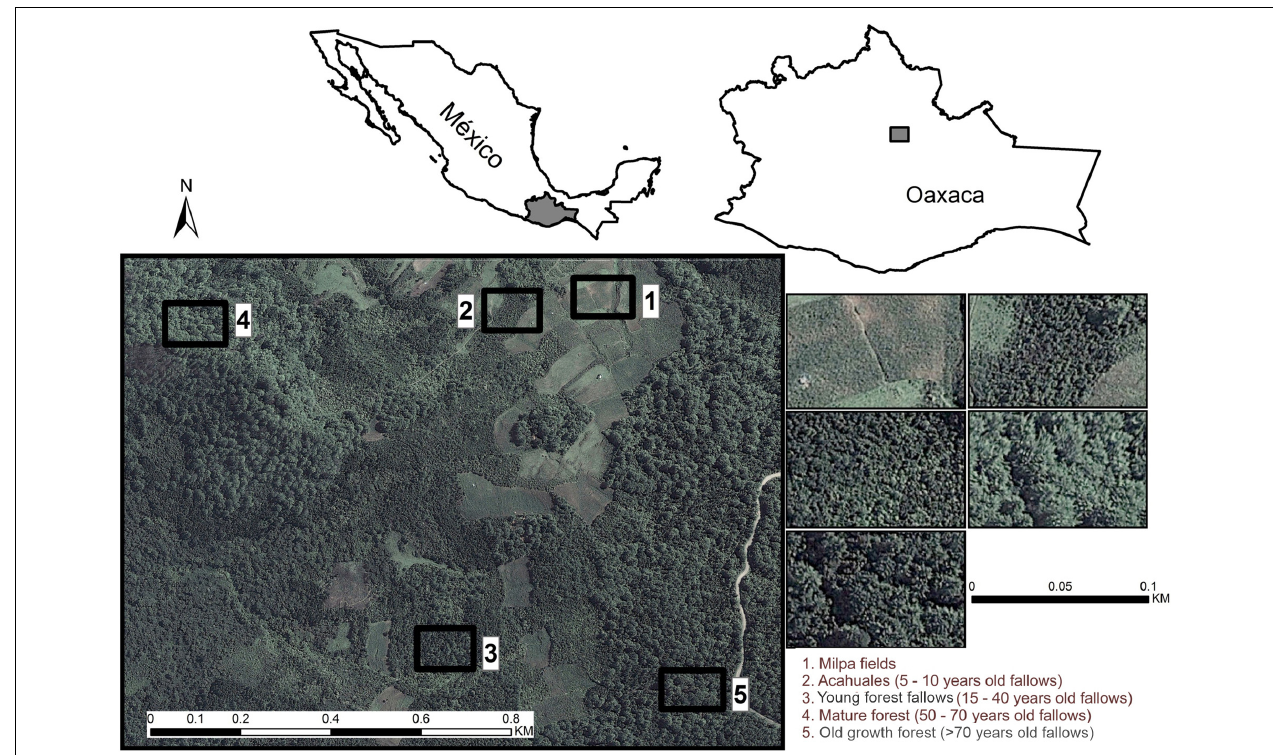
FIGURE 7 | The appearance of landscapes communicates cultural values (Iverson Nassauer, 1995), as on the windward side of the Sierra Norte mountains, Oaxaca, Mexico (1,300–1,800 m elevation). The milpas and their associated secondary vegetation constitute a biocultural landscape resulting from the cultural transmission and adaptive management that have prevailed for > 5,000 years. The landscape is a mosaic of crop fields and vegetation fragments of different ages resulting from small land pieces previously cultivated and set idle at different times in the past after the cultivation phase. Young forest fallows are dominated by Pinus chiapensis . Old-growth fallows are typical montane cloud forests. Reproduced from del Castillo (2015) by permission of Ecological Applications© John Wiley and Sons (2015).